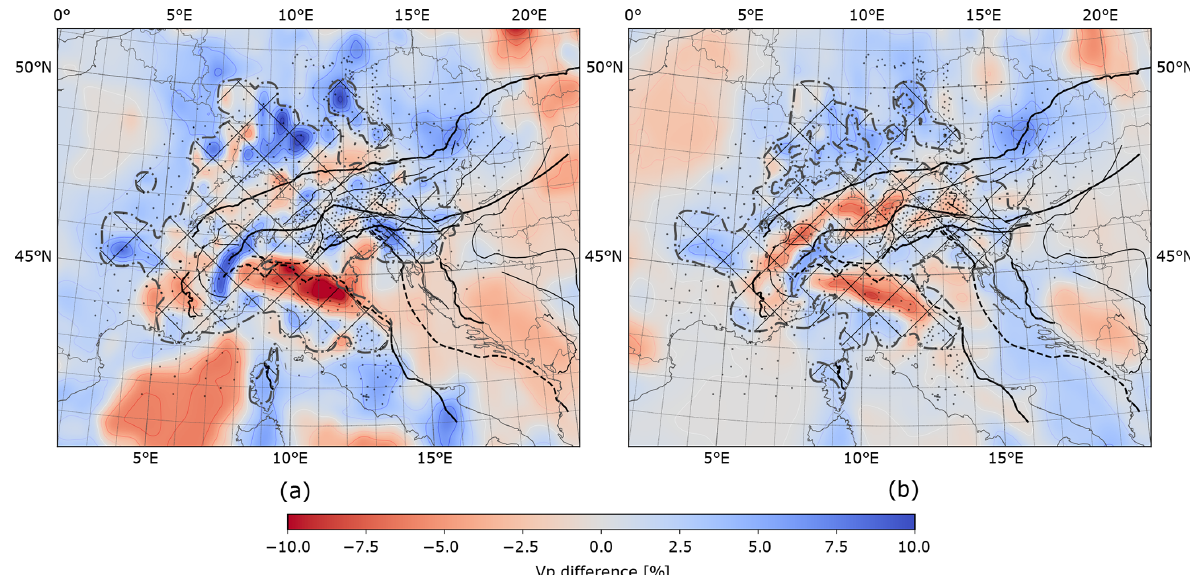
Figure 2. Two horizontal slices through the (smoothed) crustal model at (a) 15km and (b) 30km depth. Colours show the difference in P-wave velocity to the one-dimensional background model. Dashed–dotted line indicates boundary between the two models of Diehl et al. (2009) (cross-hatched area) and Tesauro et al. (2008).